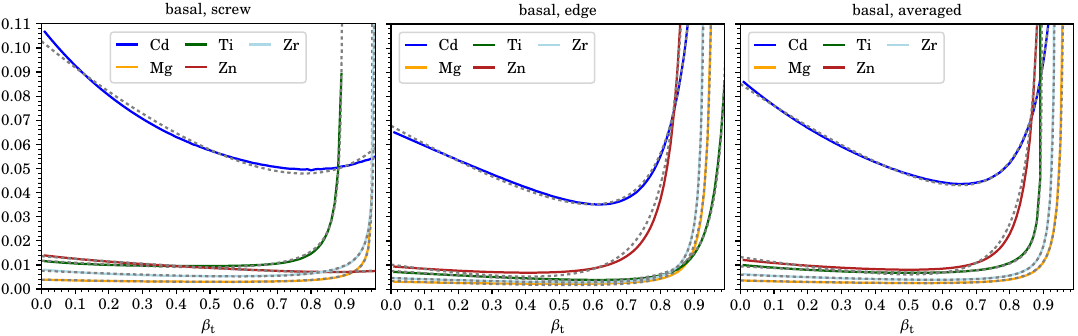
Figure 3. We show the drag coefficient B ( β T ) from phonon wind for pure screw and edge dislocations as well as averaged over all character angles ϑ for basal slip of five hcp metals. Dashed lines represent the fitting functions and β T = v / c T